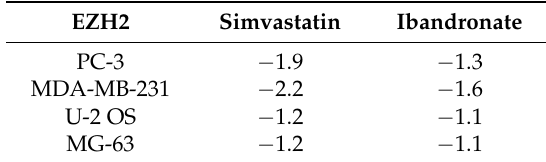
Table 11. Fold downregulation of the histone methylase EZH2 . EZH2 Simvastatin